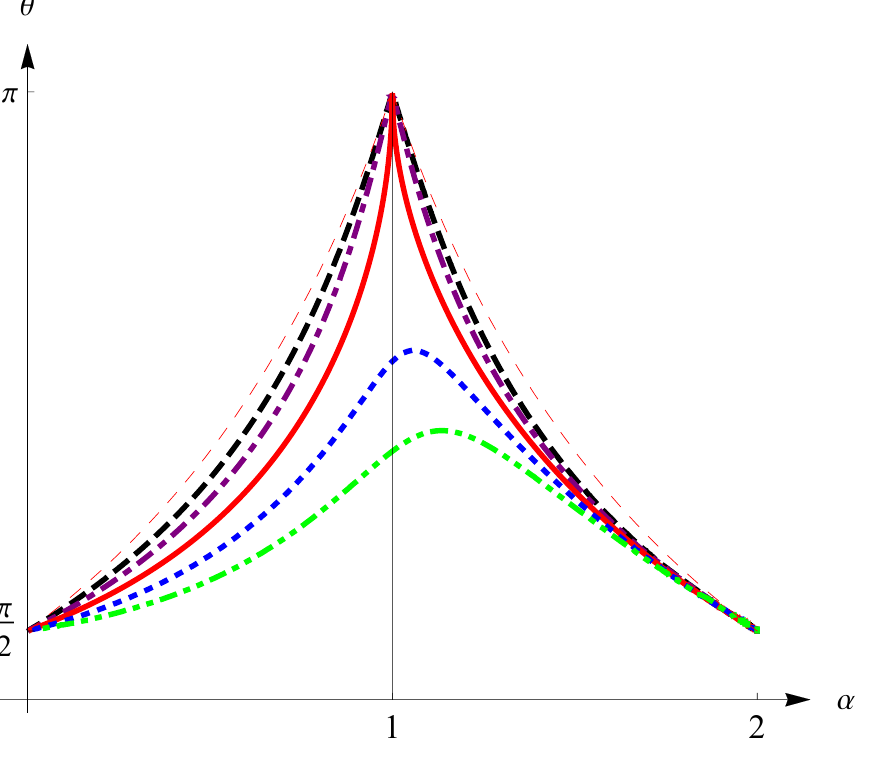
Figure 3. Curves of θ ( α ) vs. α for b = 4 and for different values of c : c = 1 (black dash line), 2 (purple dot-dash line), 4 (red solid line), 8 (blue dot line) and 16 (green dot-dot-dash line). In Figure 3, dash line and dot-dash line are for the case of b 2 − 4 c > 0, solid line is for the case of b 2 − 4 c = 0 and dot line and dot-dot-dash line are for the case of b 2 − 4 c <